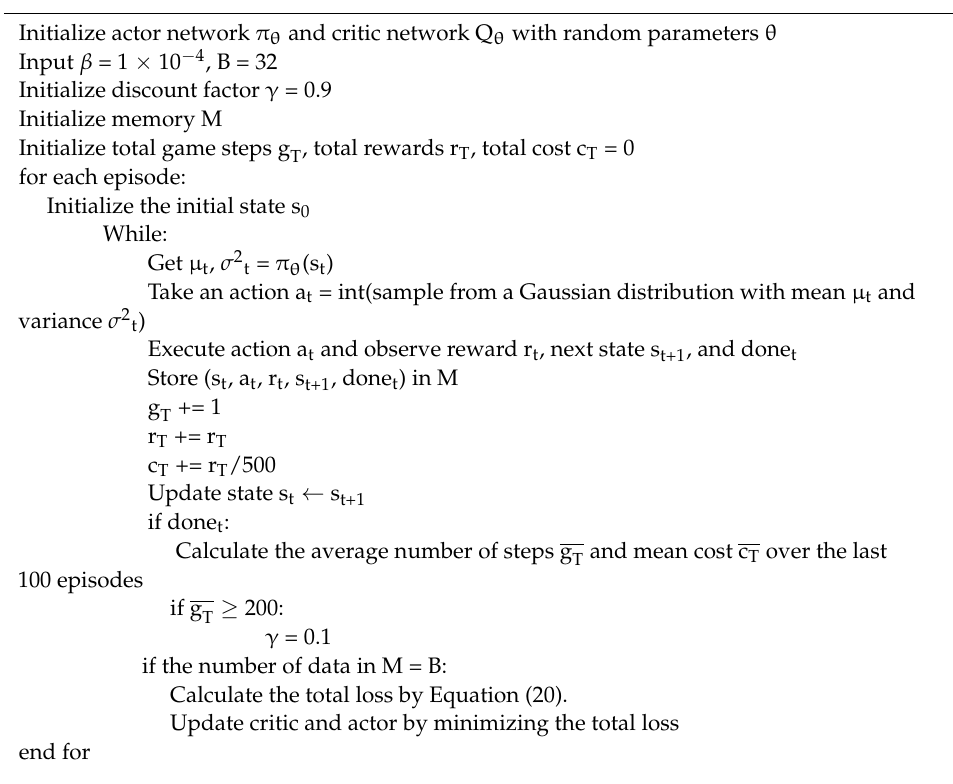
Algorithm 1. Proposed A2C Model for a Continuous Action Space with a